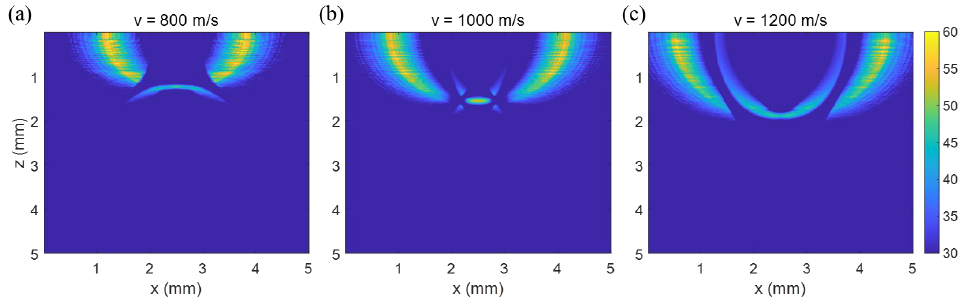
Figure 4. Image reconstruction of a LUS signal made with different acoustic velocities. The acoustic velocity was assumed ( a ) 800 m/s, ( b ) 1000 m/s, and ( c ) 1200 m/s. The image was well matched with the original when it was reconstructed with the velocity of 1000 m/s used to simulate the B-scan image.